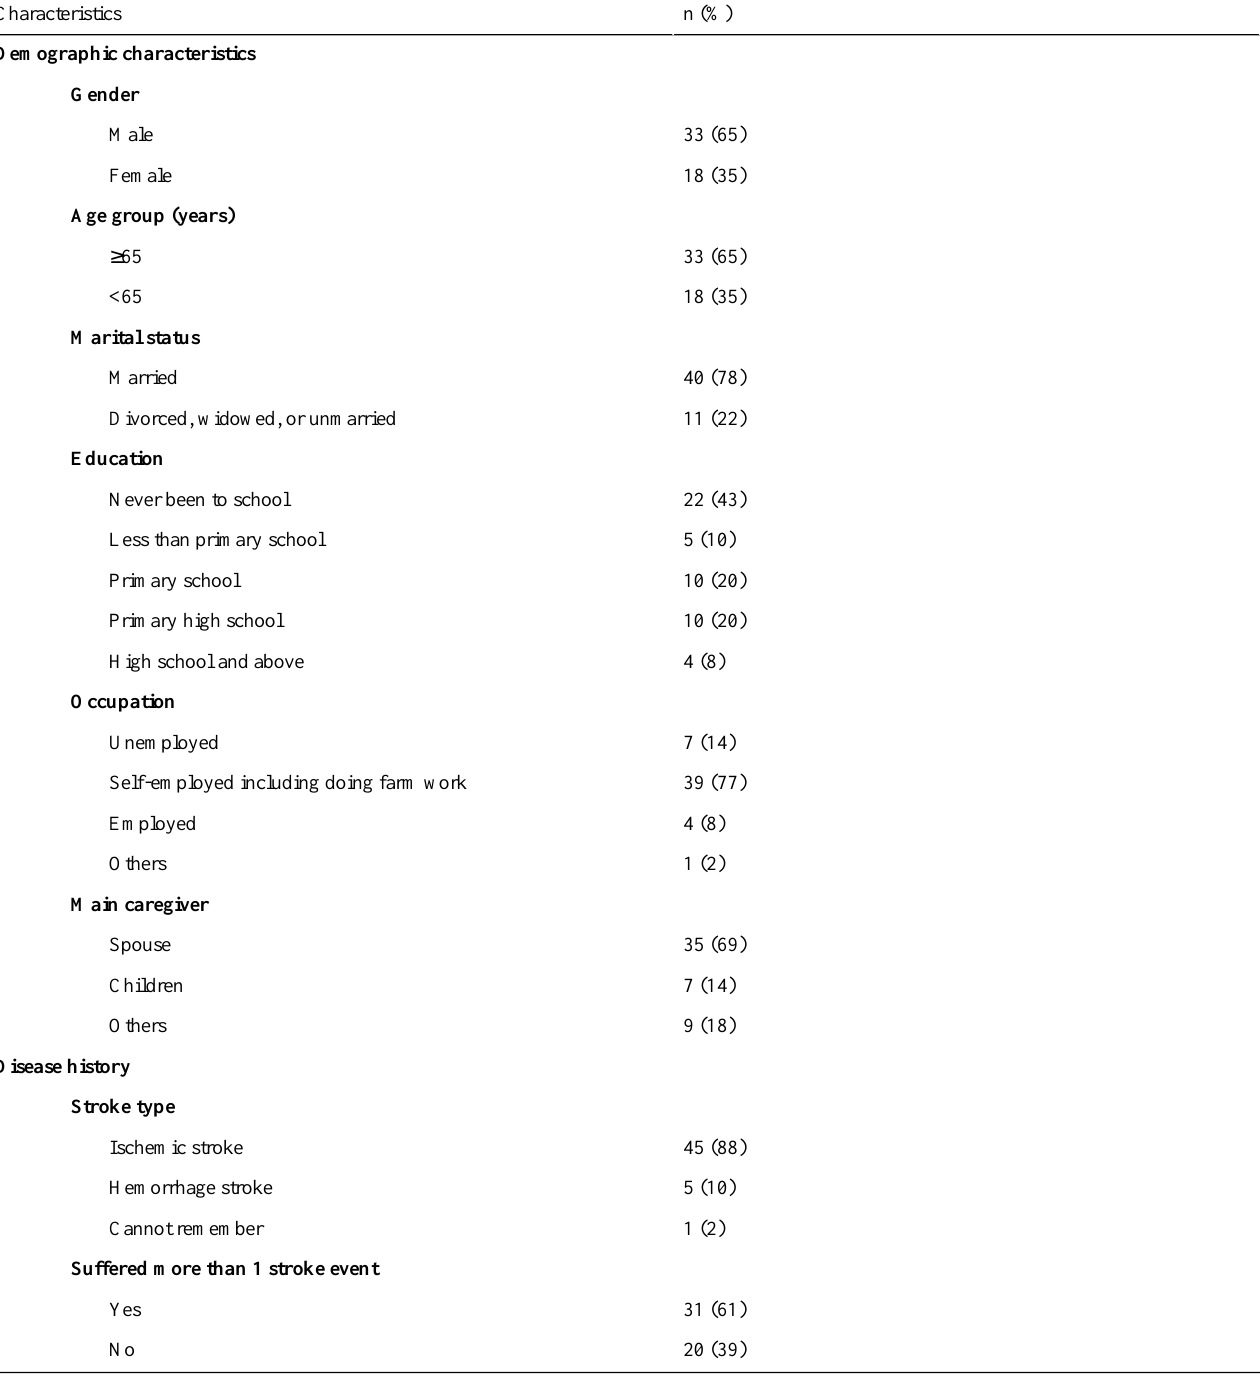
Table 1. Demographic characteristics and disease history of participants who responded to the feedback survey